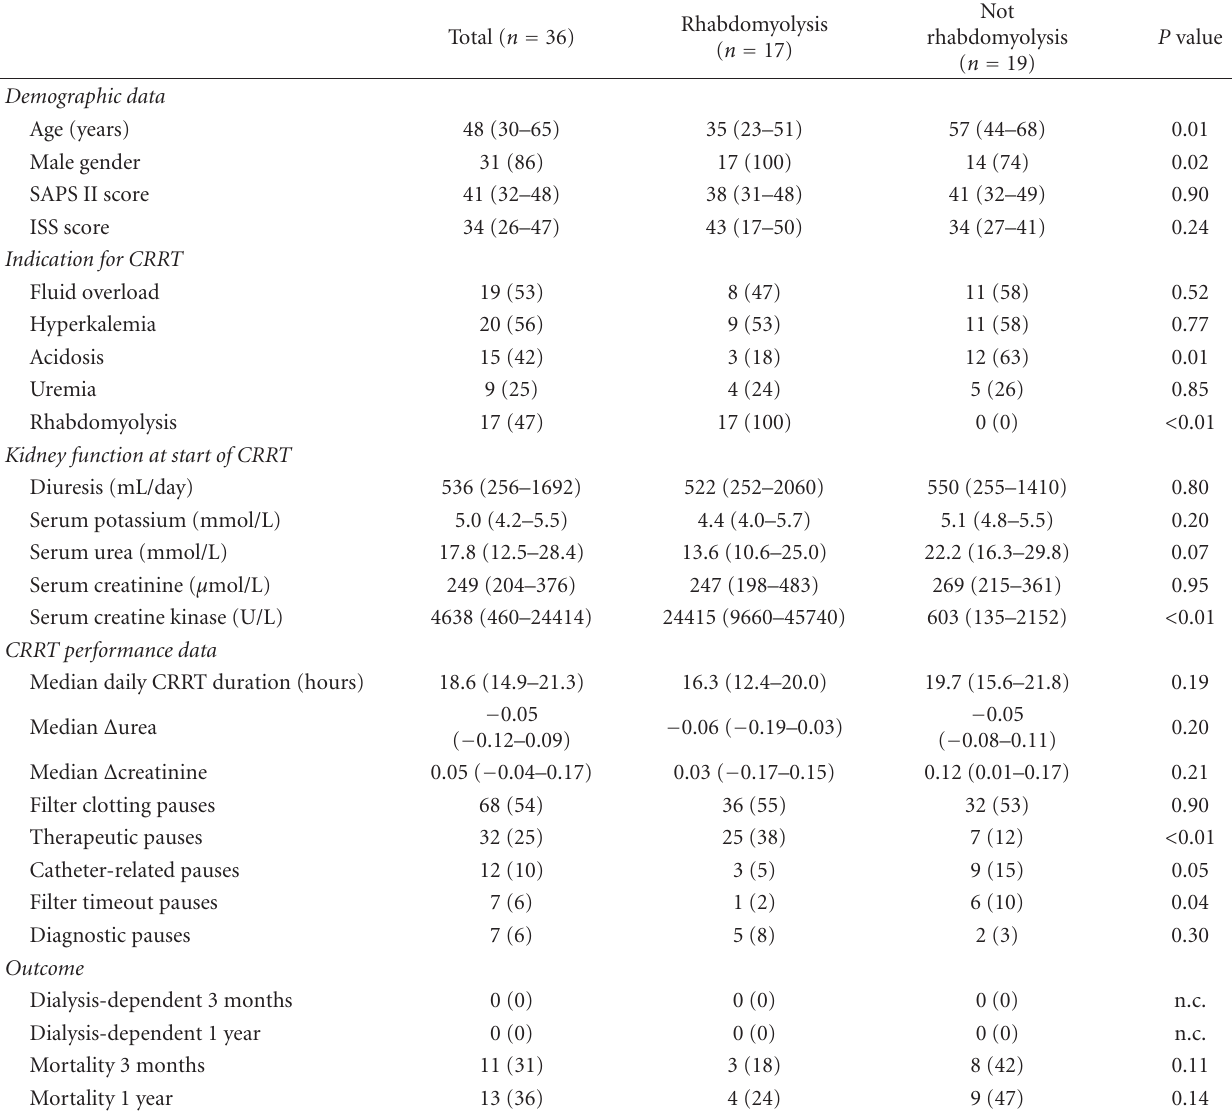
Table 1: Patient characteristics: Trauma patients with acute kidney injury with continuous renal replacement therapy (CRRT) grouped with and without rhabdomyolysis ( n =